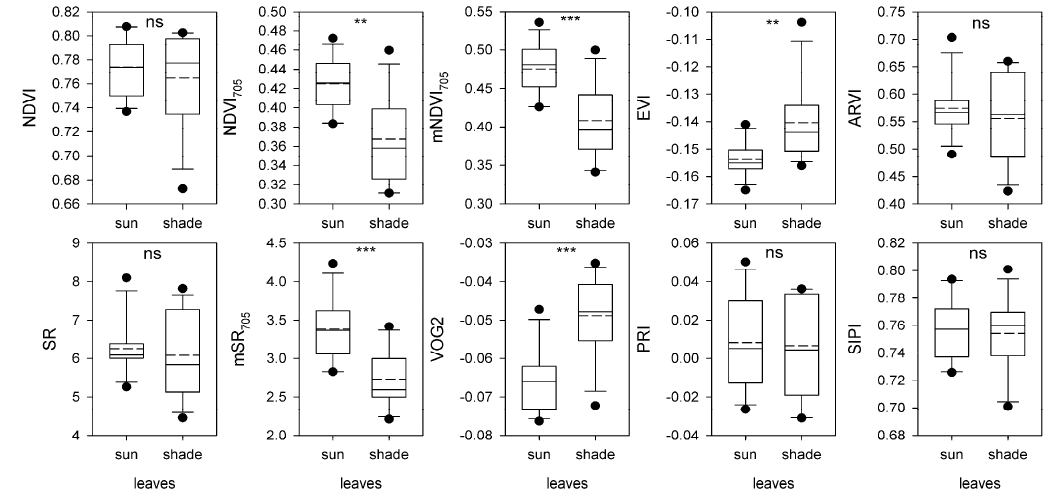
Figure 8. Boxplots of major vegetation indexes of sun and shade leaves of Phragmites australis . Data from different leaves were compared with Mann-Whitney Rank Sum Test: ns—Not significant, ** p < 0.01, *** p < 0.001.